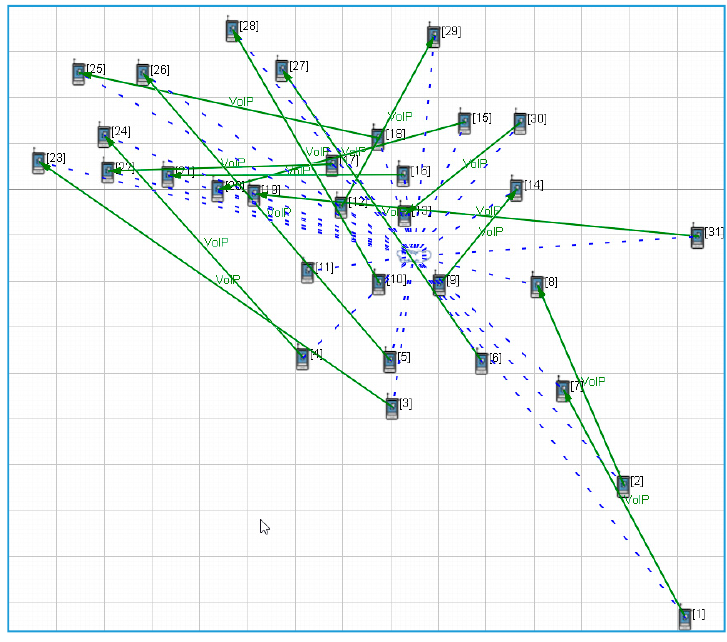
Figure 11. Isolated village scenario.